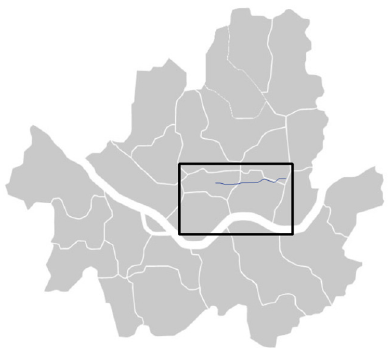
Figure 1. Seoul, with the location of Cheonggyecheon in the box, north of the Han River.